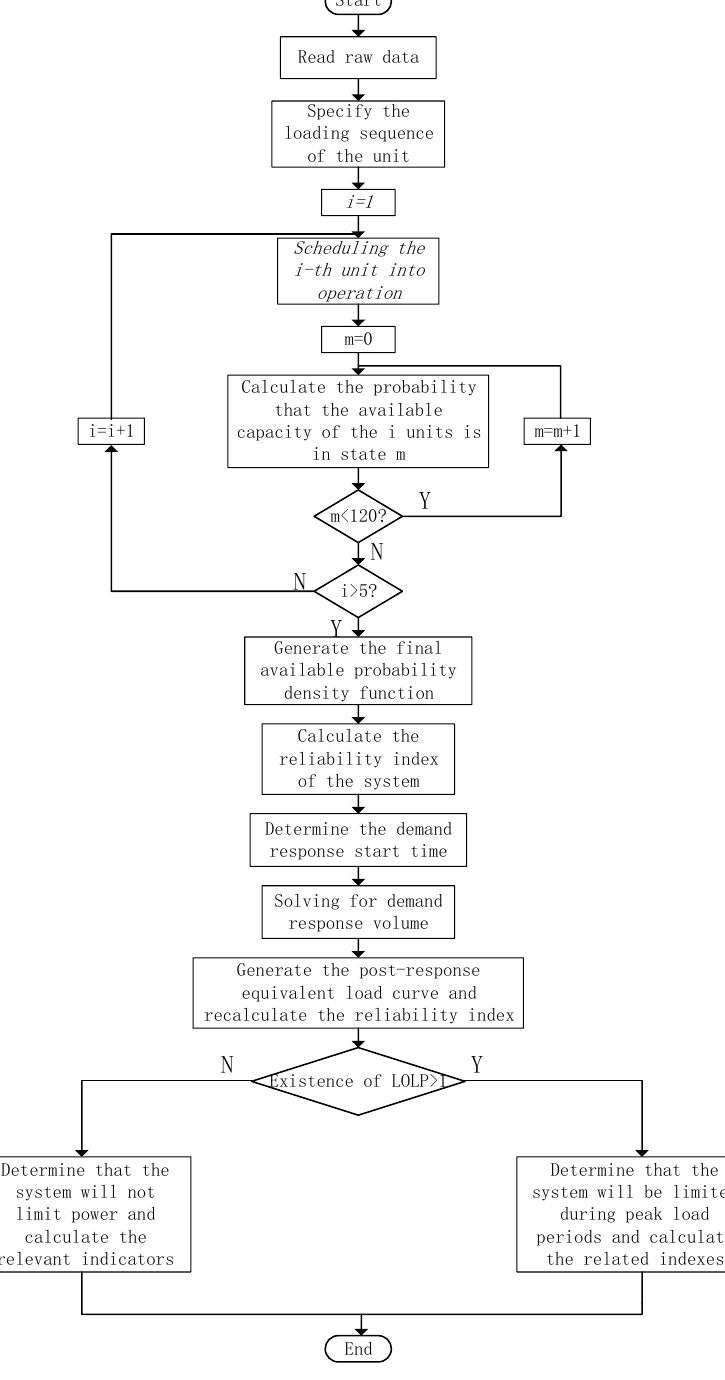
Figure 3. Demand response optimization peak shaving algorithm flowchart.